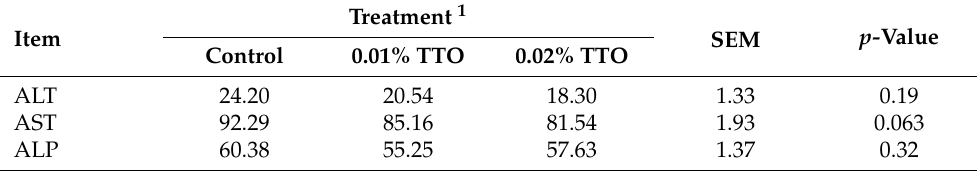
Table 3. Effects of TTO on serum-enzyme-related indices of bovine in postpartum period.